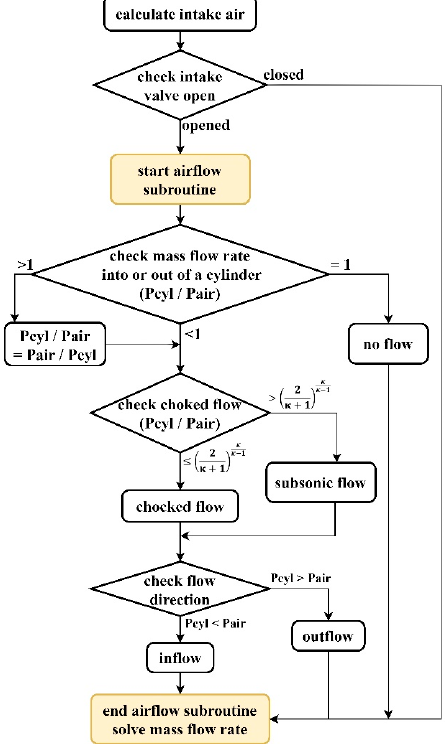
Figure 4. Algorithm for calculating the intake mass flow rate of the one-dimensional gas flow analysis program.